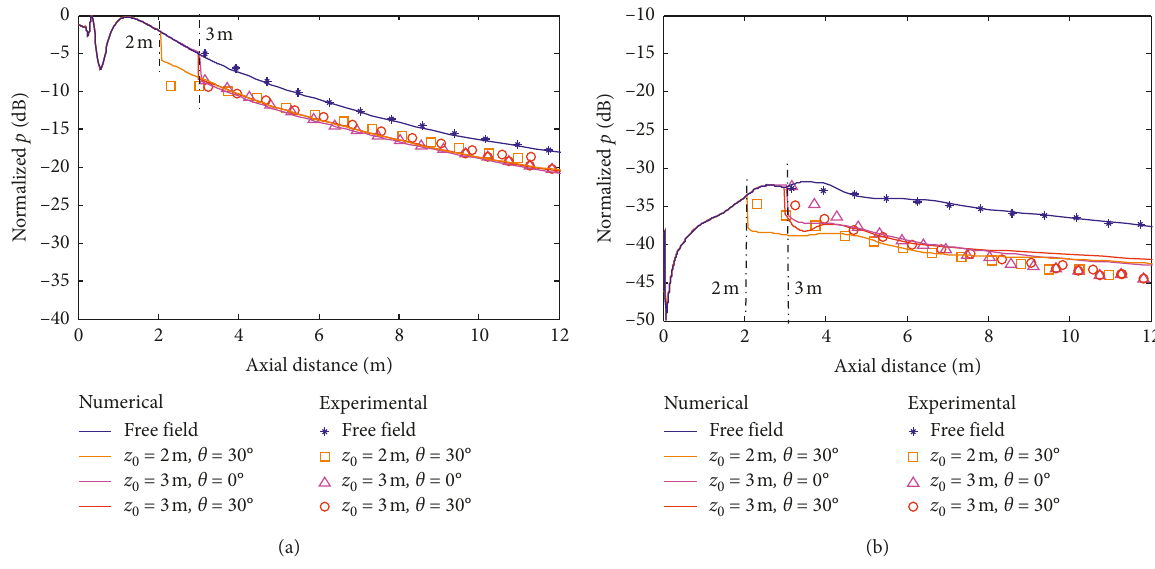
Figure 8: The axial sound pressure distribution of sound pressure. (a) The primary sound pressure f � 95 kHz. (b) The difference frequency sound pressure f �